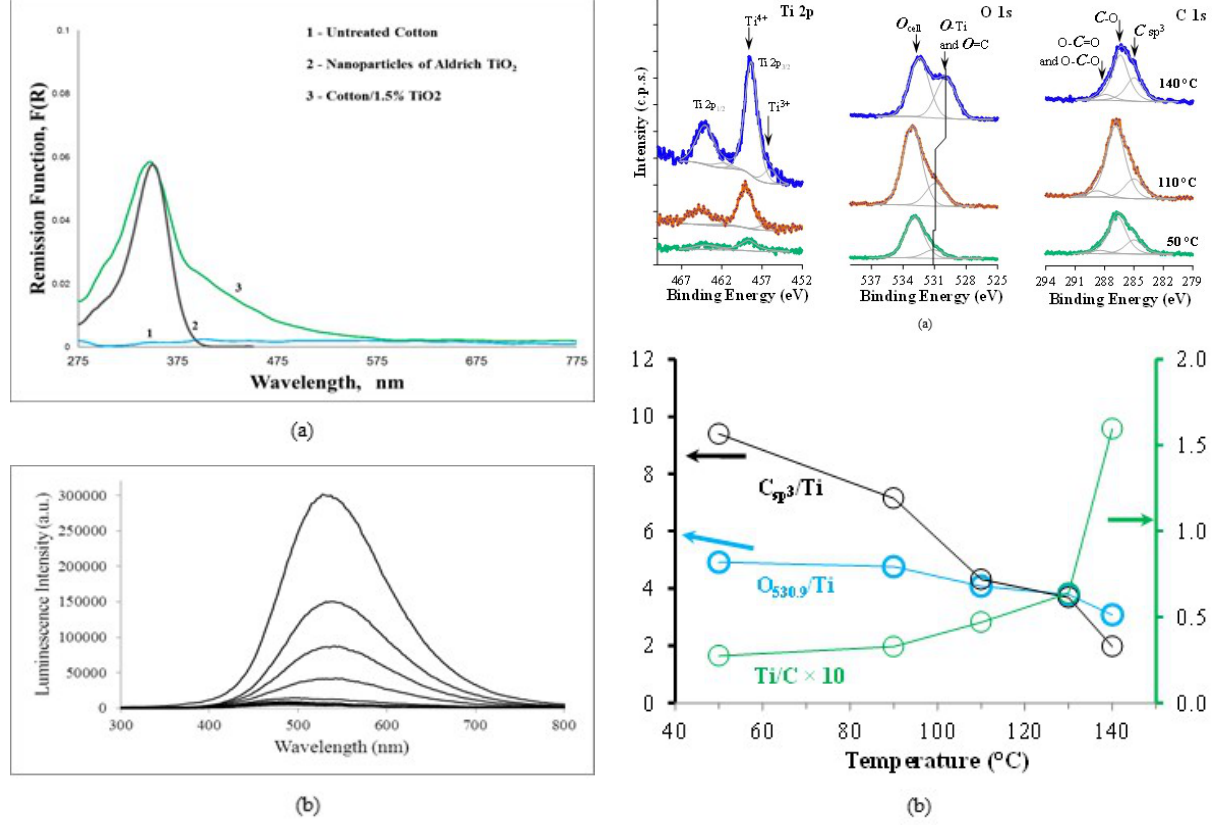
Figure 4: a) GSDR of untreated cotton, commercial TiO 2 nanoparti- cles and Cotton impregnated with 1.5% TiO induced luminescence of cotton impregnated with 1.5% TiO the time interval between curves is 1 µ s